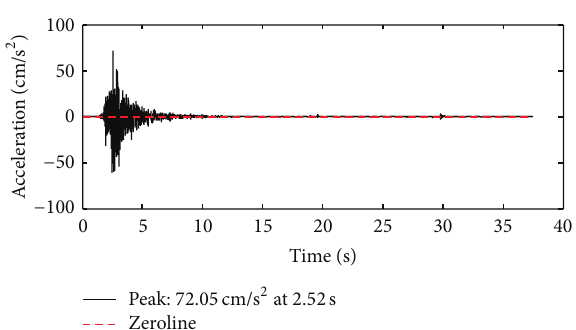
Figure 8: Acceleration time history (NZHVSC.raw, UP, ratl = 2.00, ratr = 1.12).